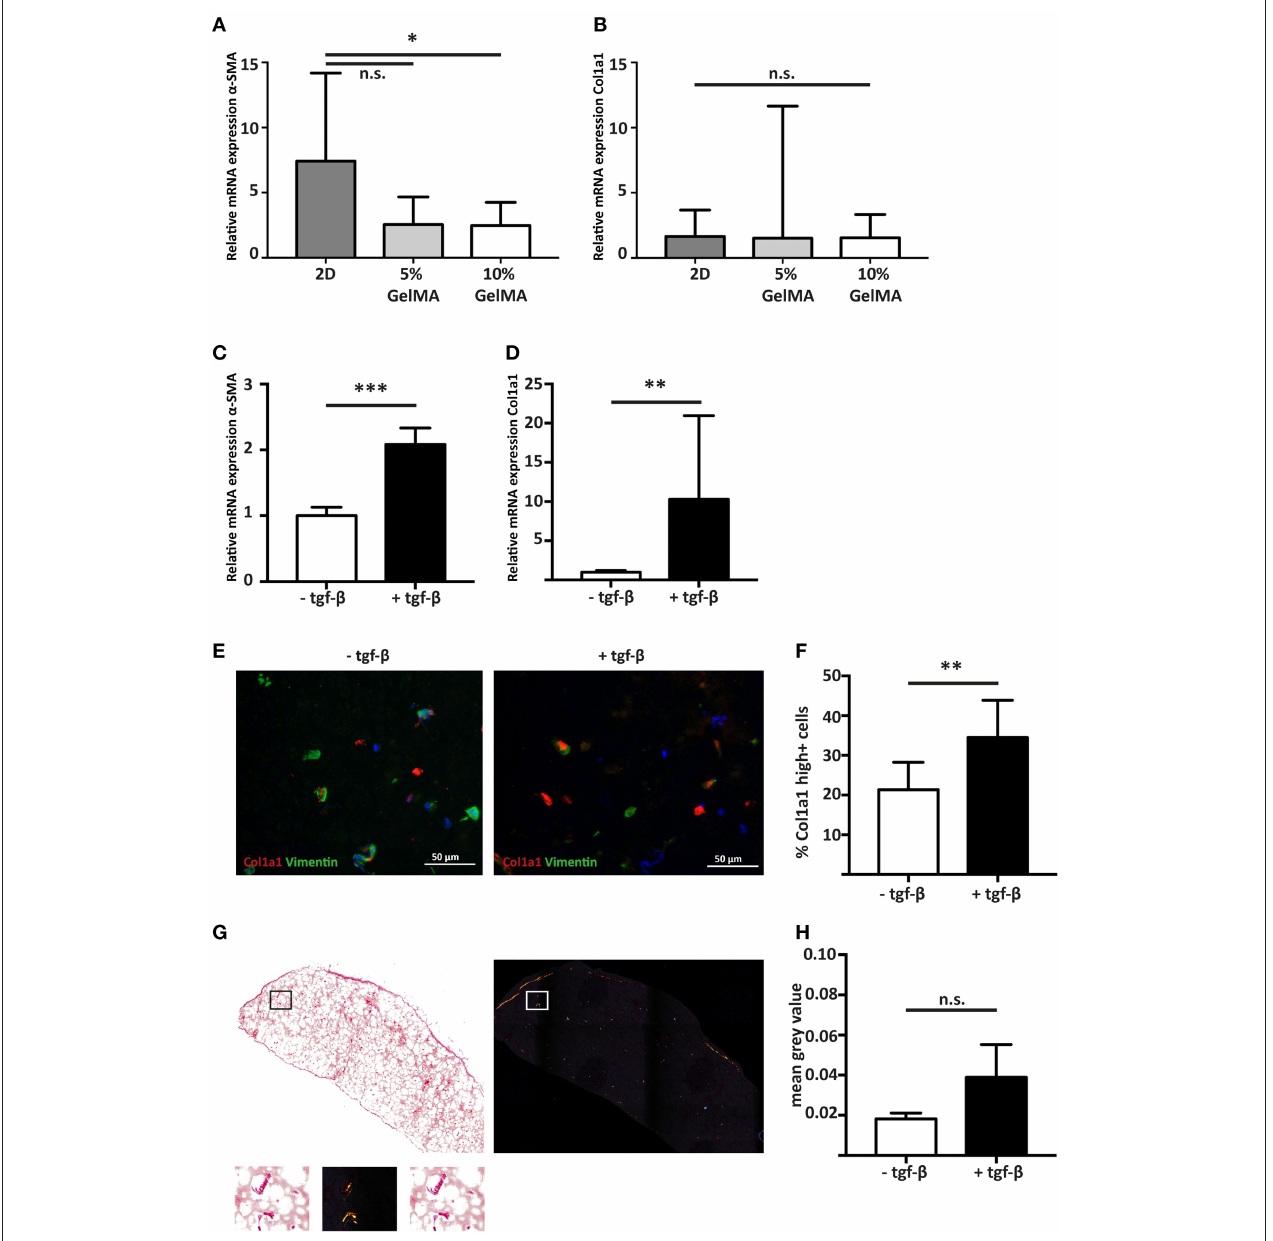
FIGURE 3 | Stimulating cardiac fibroblast mediated fibrosis with the pro-fibrotic mediator TGF- β 1. (A) Gene expression analysis shows that hfCF have a lower α -SMA expression after 7 days of culture when encapsulated in 5% (w/v) or 10% (w/v) GelMA ( n = 8). Statistical significance was assessed using one-way ANOVA with a Dunnett post-hoc test. * p < 0.05. (B) Col1a1 expression remains equal. Values are relative to the corresponding 2D cultured hfCF at day 1 ( n = 8). Statistical significance was assessed using one-way ANOVA. (C) Stimulation with TGF- β 1 for 7 days results in a 2.1-fold increase in α -SMA expression and (D) a 10.3-fold increase in Col1a1 expression ( n = 8). Statistical significance was assessed using paired student’s t -test (two-tailed). *** p < 0.001 ** p < 0.01. (E,F) Immunohistochemistry shows an increased number of highly Col1a1 positive cells upon stimulation with TGF- β 1 (Col1a1 = red, vimentin = green, nuclei = blue). Statistical significance was assessed using paired student’s t -test (two-tailed). ** p < 0.01. (G,H) Accumulation of collagen fibers in the extracellular matrix is demonstrated by picrosirius red staining and quantification ( n = 4). Left panel = bright field image. Right panel = polarized light image. Lower panel shows a higher magnification of the box. Statistical significance was assessed using paired student’s t -test (two-tailed).